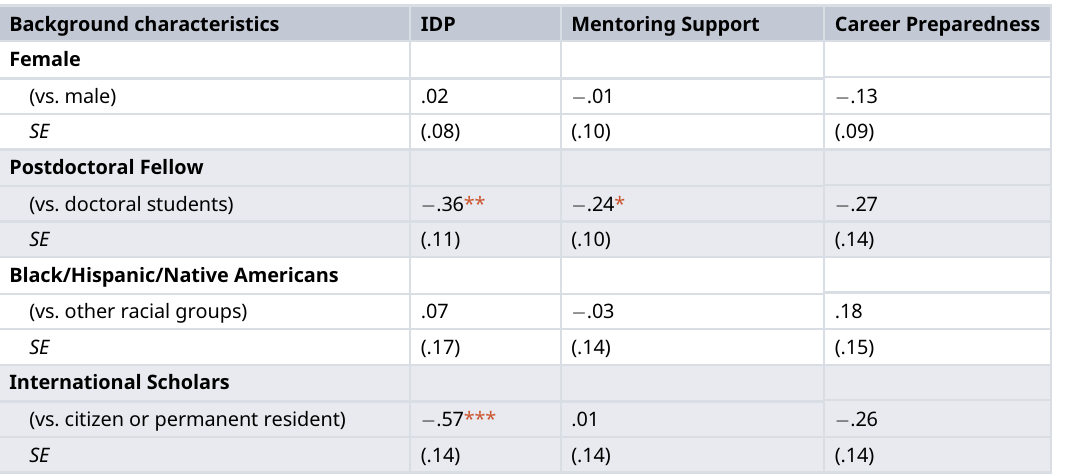
Table 2. Standardized mean differences by background characteristics.